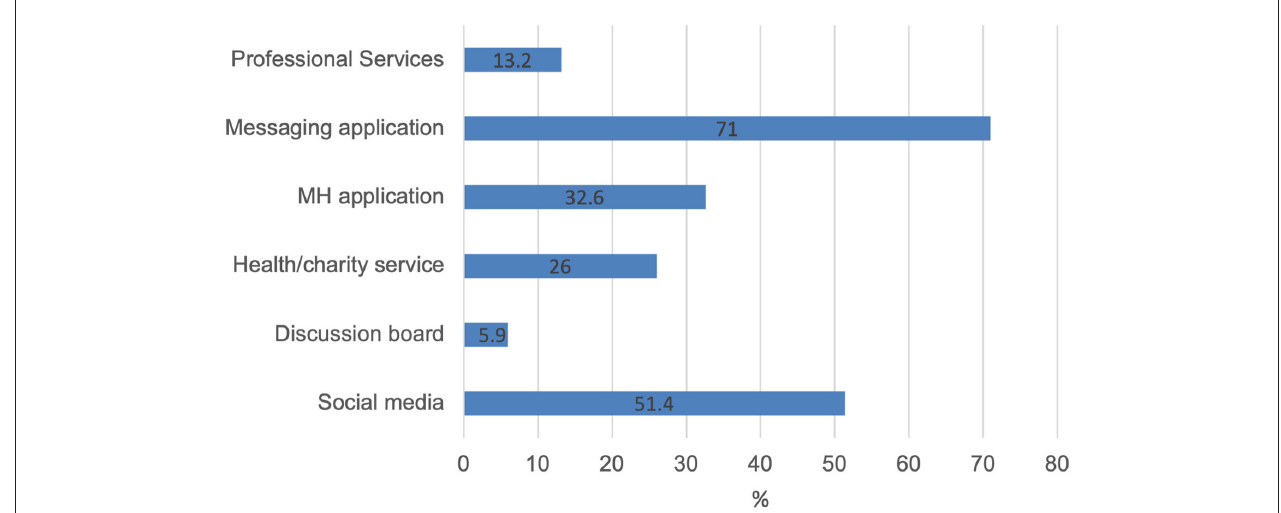
FIGURE 1 | Digital tools used to support mental